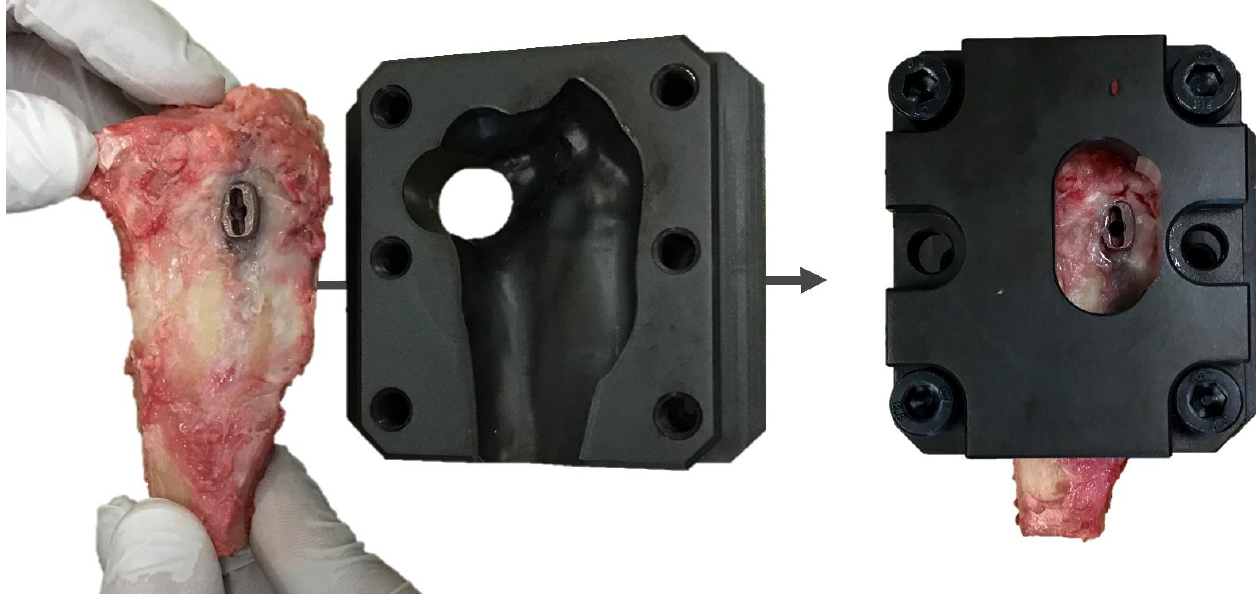
Figure 4. Image of a custom jig for stable fixation of the proximal tibia in the testing machine. The TTA CF cage has a threaded hole on its medial longest edge for screwing the drill guide (Figure 5).